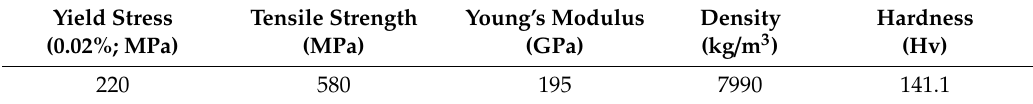
Table 1. Mechanical properties of ST 316L